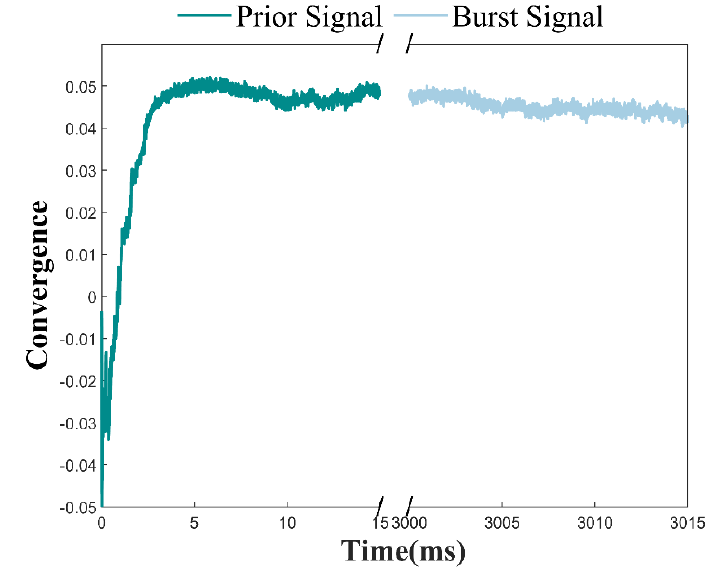
Figure 9. The convergence of the robust anti-jamming algorithm.